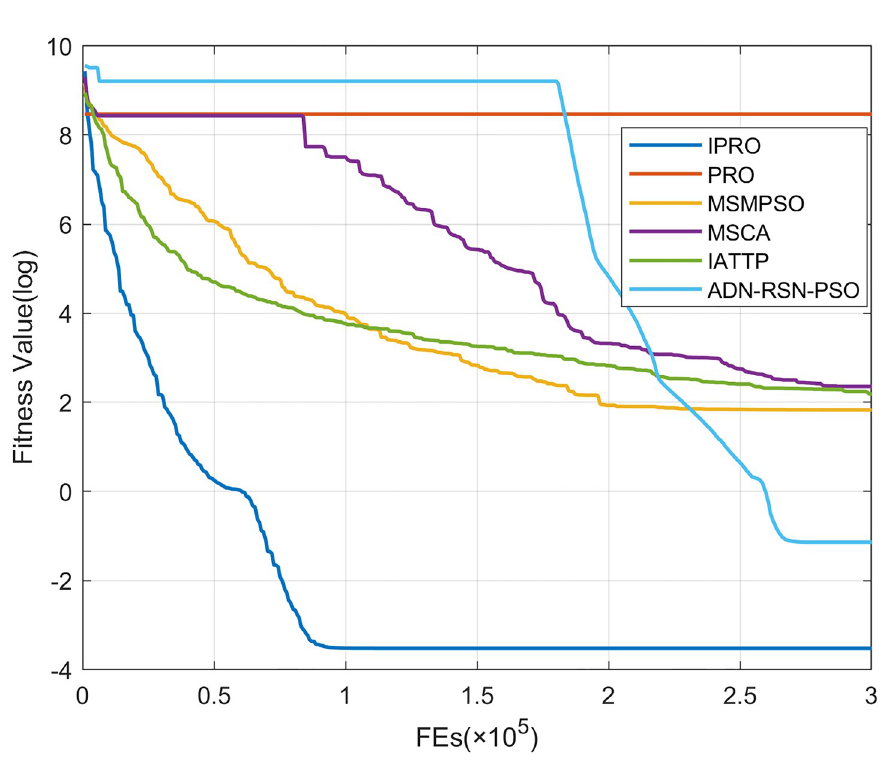
Fig 10. Convergence curves on